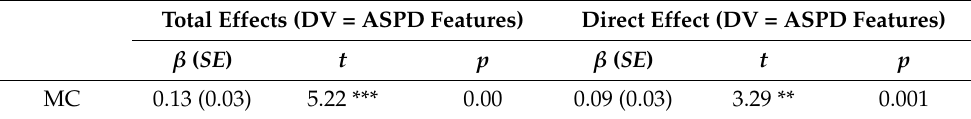
Table 2. Total effect and direct effect.